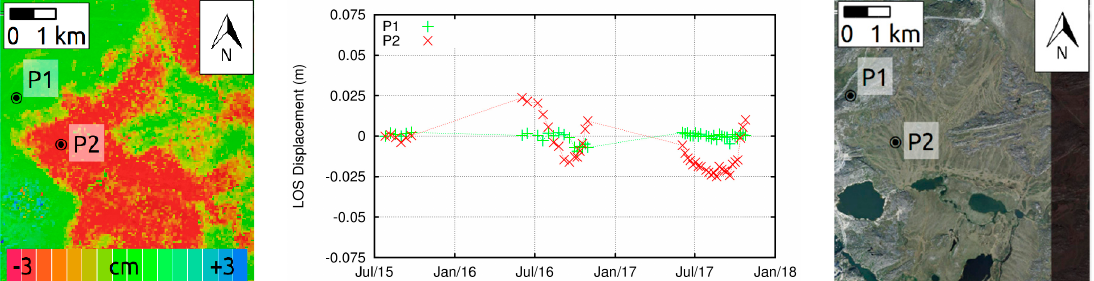
Figure 6. Time series of displacement in the line ‐ of ‐ sight direction over an outcrop area (P1) and on peat terrain underlain by fine ‐ grained marine sediments (P2) within the Ilulissat site. For location see Figure 5. Map data are from Google, DigitalGlobe.